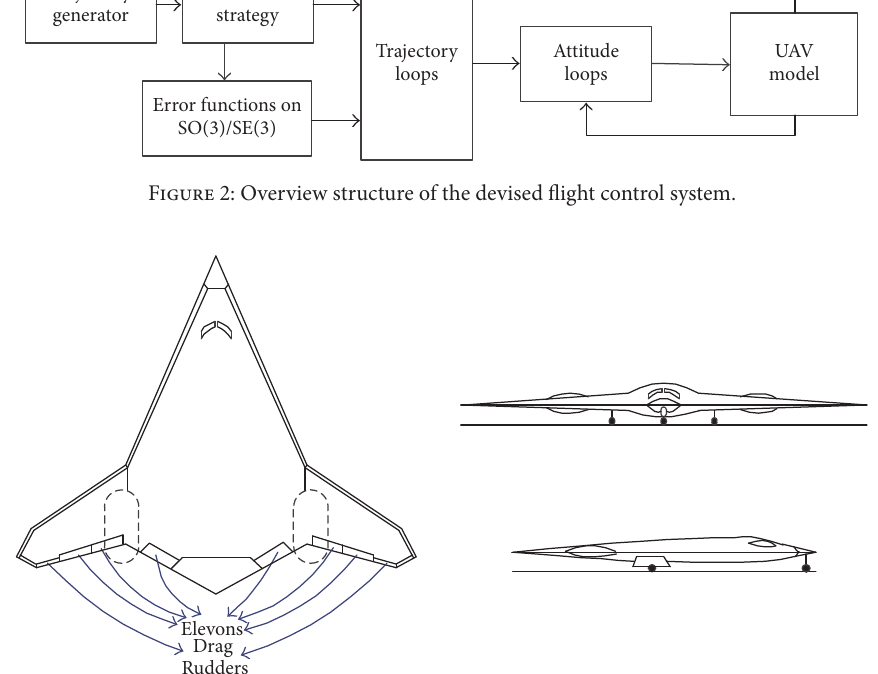
Figure 3: Three-view drawing of the UAV used in the simulations. R frame { H } and 𝜔 ∧ 𝐻 ∈ 𝑠𝑜(3) , N = [